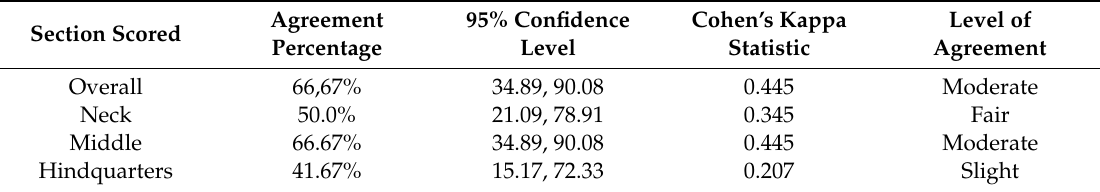
Table 3. Level of agreement between participants / researcher’s